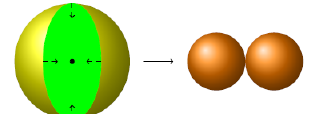
Figure 14. Transition 0-1 level of the division of TC.